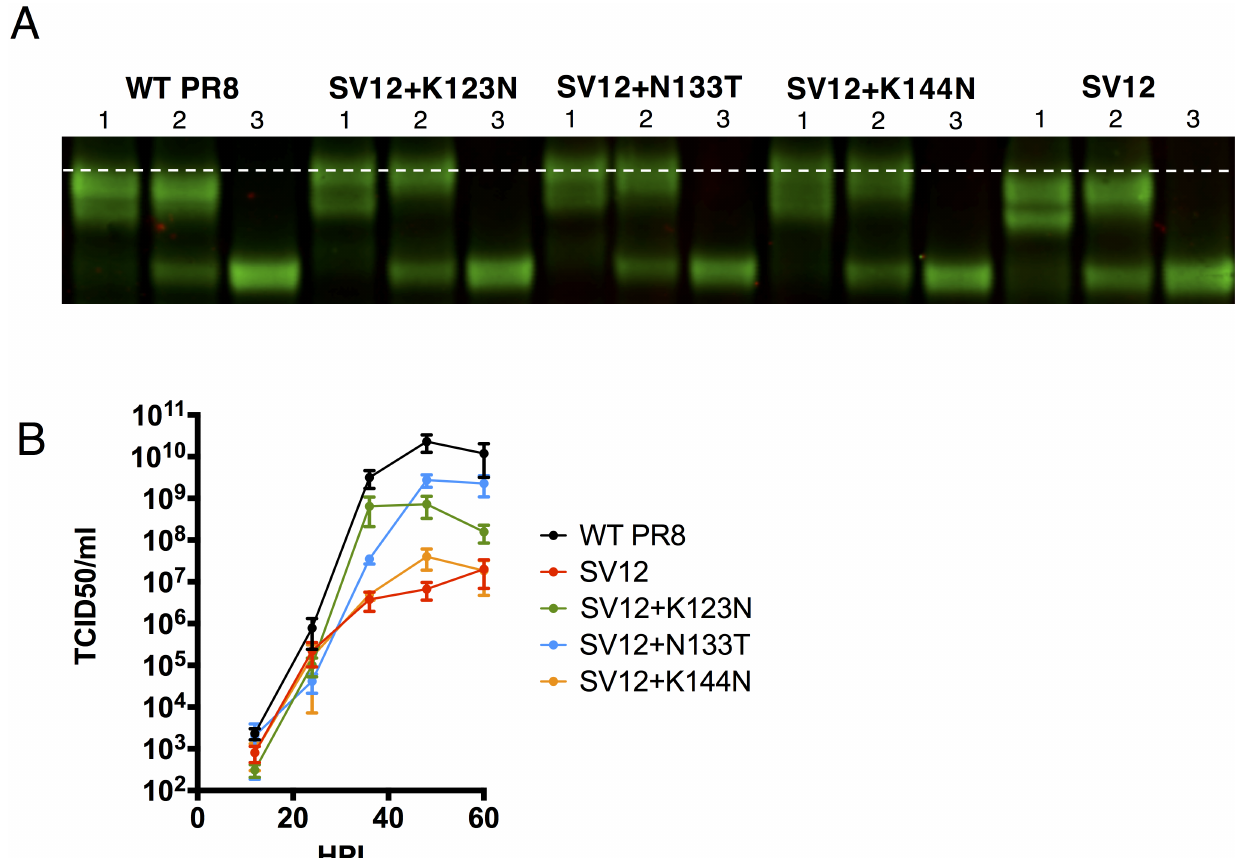
Fig 3. Characterization of compensatory glycan additions. (A) Western blot comparison of HA glycosylation mutants following endoglycosidase treatment. Treatment 1 = undigested, treatment 2 = Endo H digested, treatment 3 = PNGase digested. (B) Growth comparison of PR8, SV12, and SV12 plus individual compensatory mutations in eggs. Eggs were inoculated with 500 TCID50, and viral loads within allantoic cavities were assessed by TCID50 assay at the indicated time points.